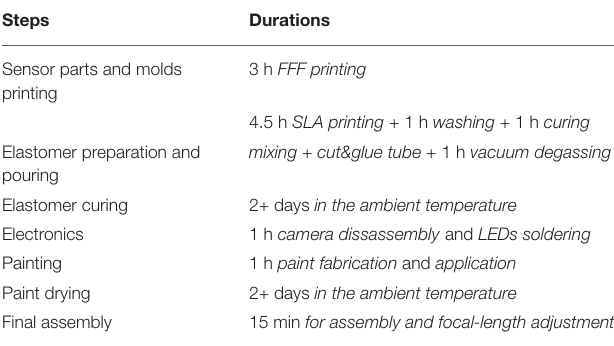
TABLE 2 | Manufacturing steps and their corresponding approximate